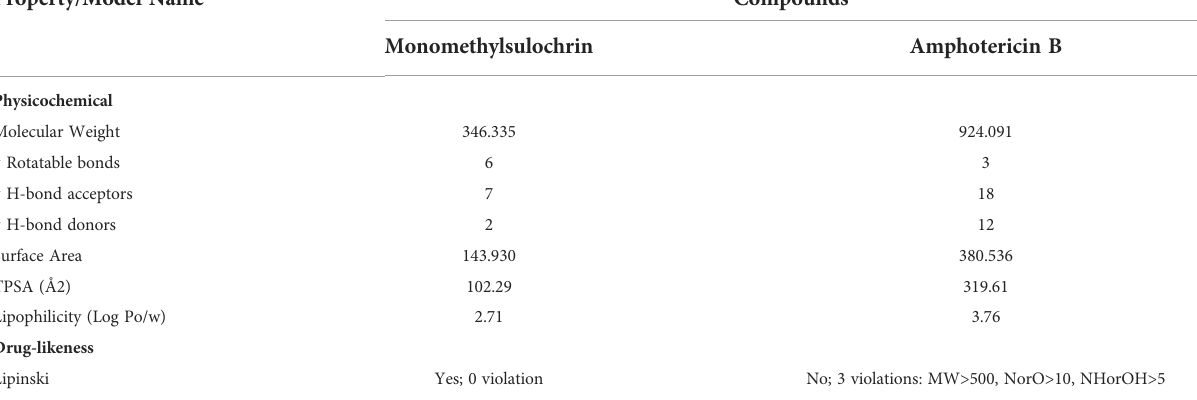
TABLE 2 Predicted physicochemical, drug-likeness, and medicinal chemistry properties for monomethylsulochrin compound and amphotericin B. Property/Model